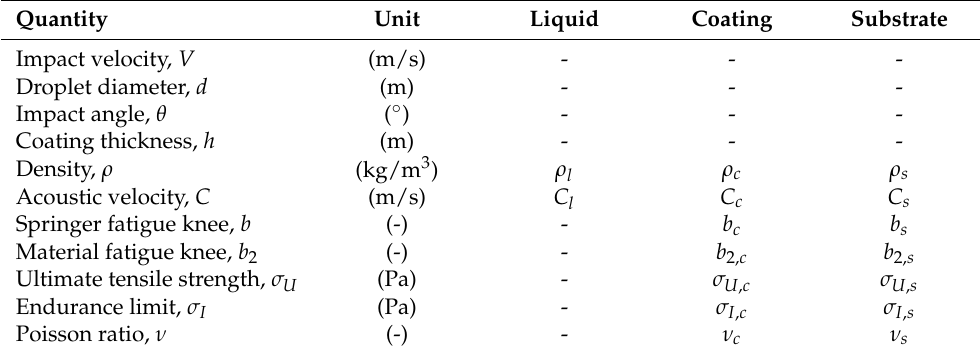
Table 1. Used quantities and corresponding units in the Springer model.